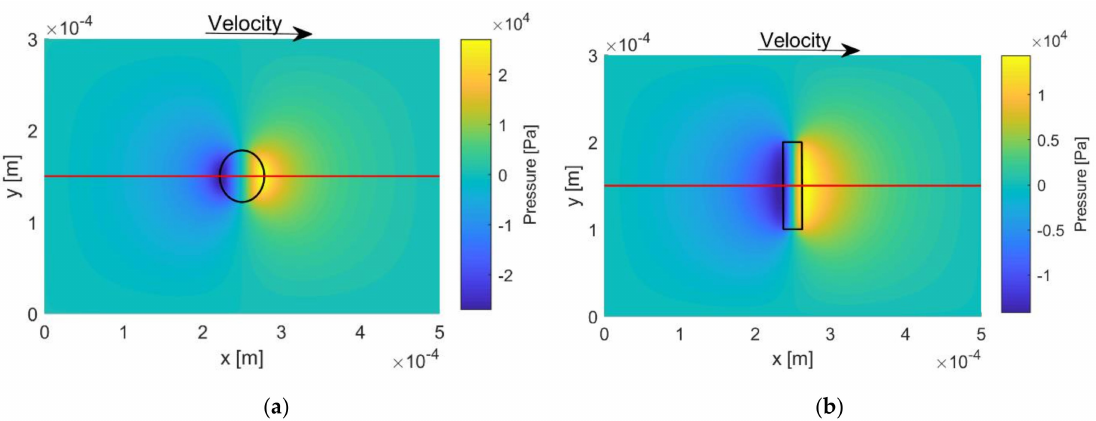
Figure 4. ( a ) Pressure contour of a circular dimple with diameter 56.4 µ m and depth 10 µ m. Gap 10 µ m, sliding velocity 5 m / s ( b ) Pressure contour of a rectangular dimple with side 100 µ m × 25 µ m and depth 10 µ m. Gap 10 µ m, sliding velocity 5 m /